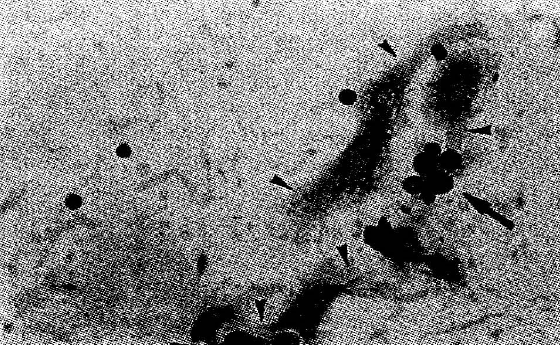
Figure 2. Bone marrow stromal cells stained in the bottom of the plastics (Petri dishes) in the long term bone marrow cultures (48 h), treated in vitro by neopterin. Stromal macrophages with enhanced adhe siveness, forming abundant cytoplasmic protrusions and long dendrite-like uropodes (arrow heads) are localized very near to the clusters of lymphocyte-like undifferentiated cells (early progenitors/stem cells; see - arrow). The same staining method with modi fica tionx Zvetkova and Zyetko\': x 6;)J i